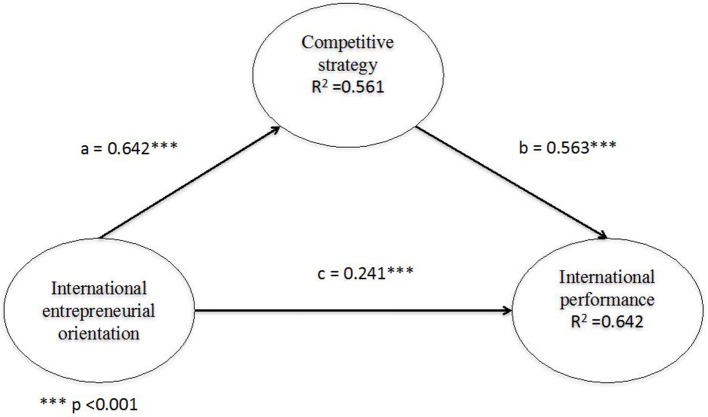
Mediation model.